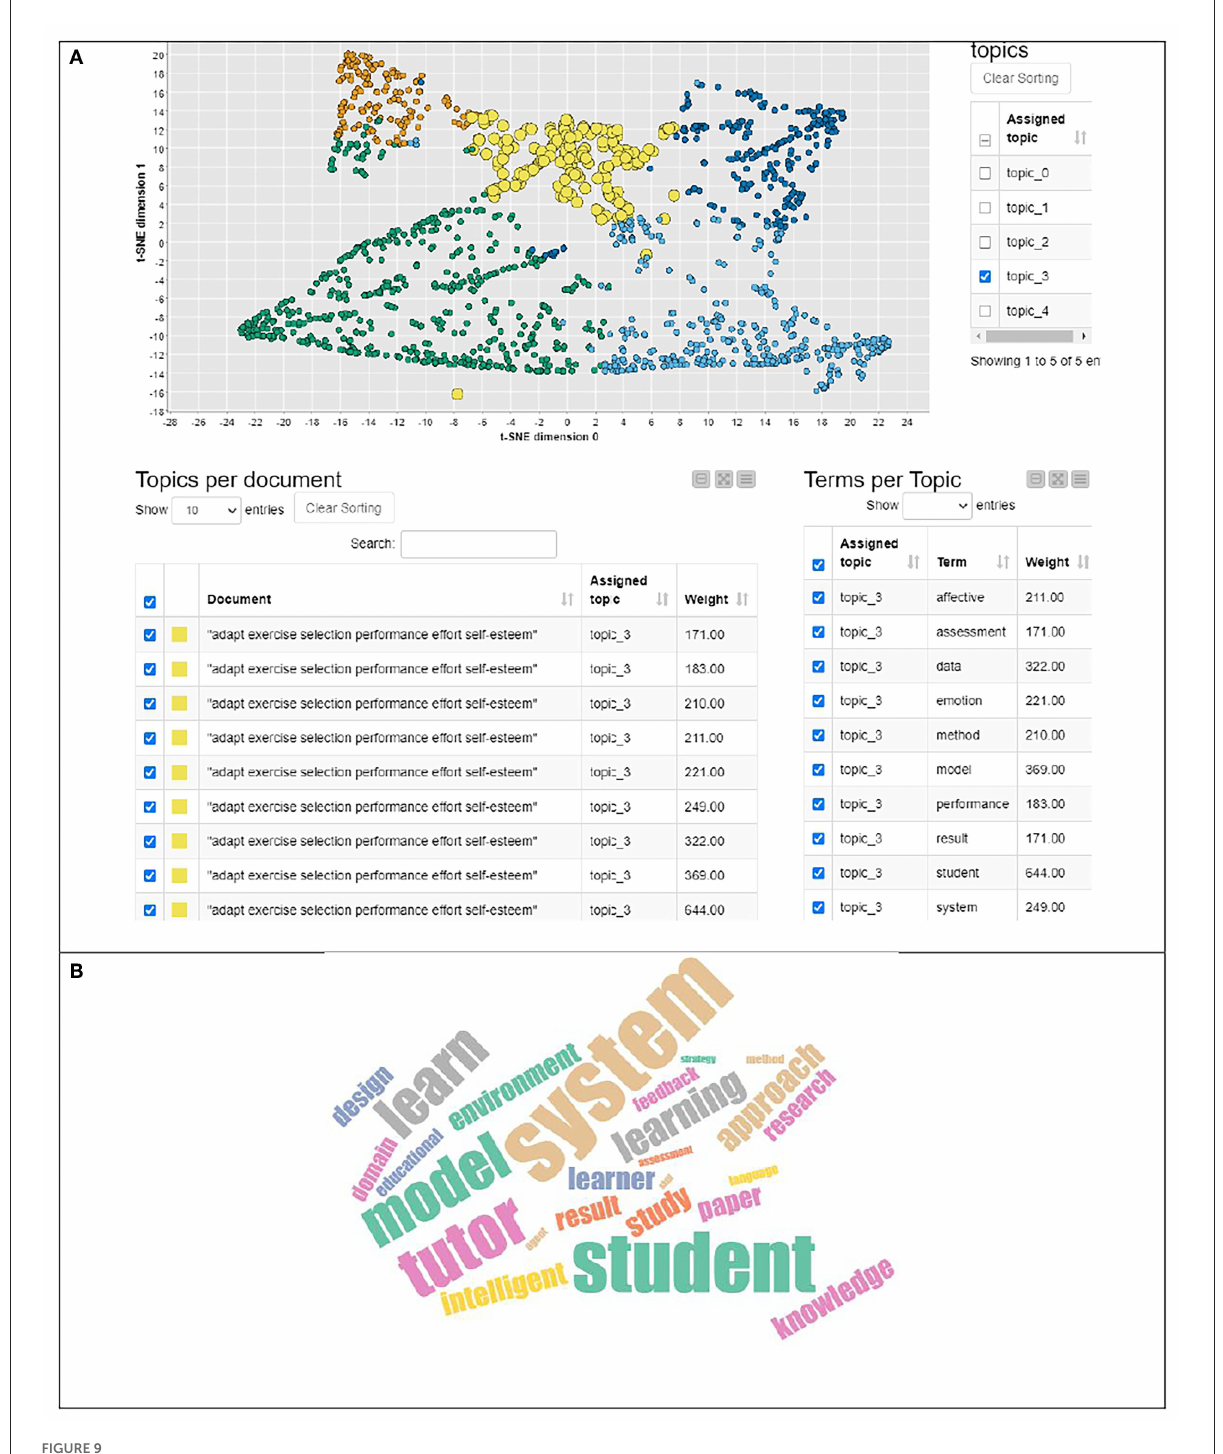
FIGURE9 (A) Inspect topics and terms, highlighting topic 3, related to the assessment and (B) Inspect topics and terms as a word